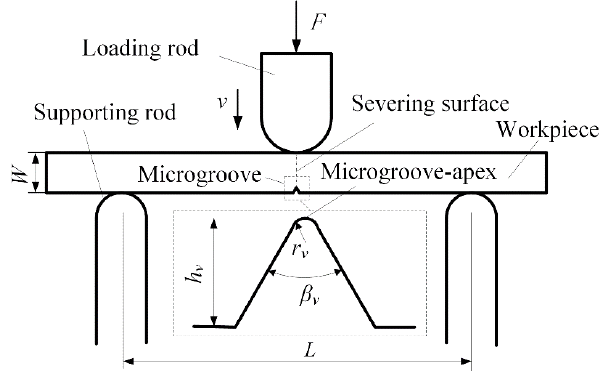
Figure 2. The scheme of micro-crack induced severing.